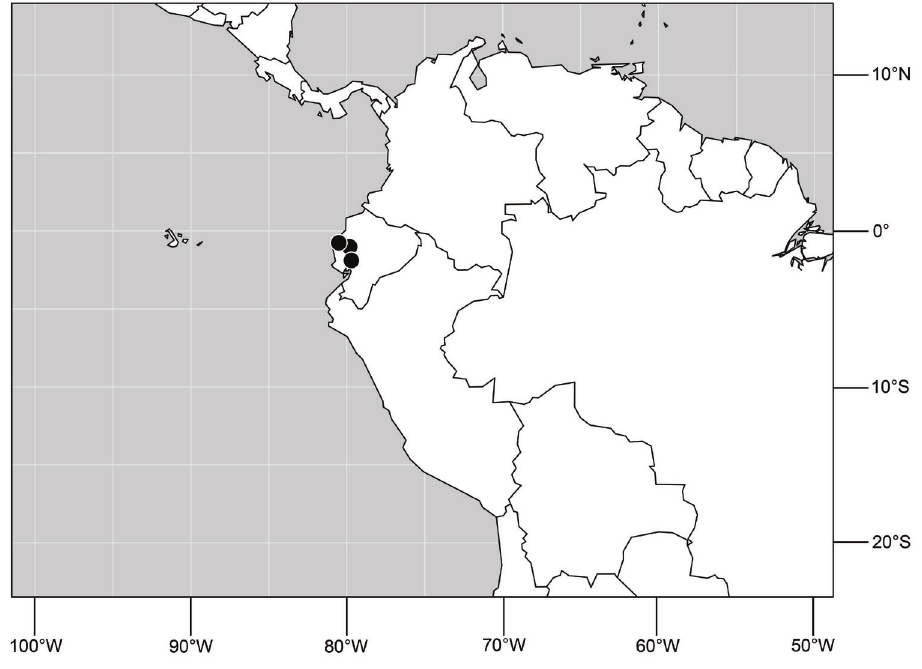
Figure 110. Distribution of Hydrochasma octogonum sp.